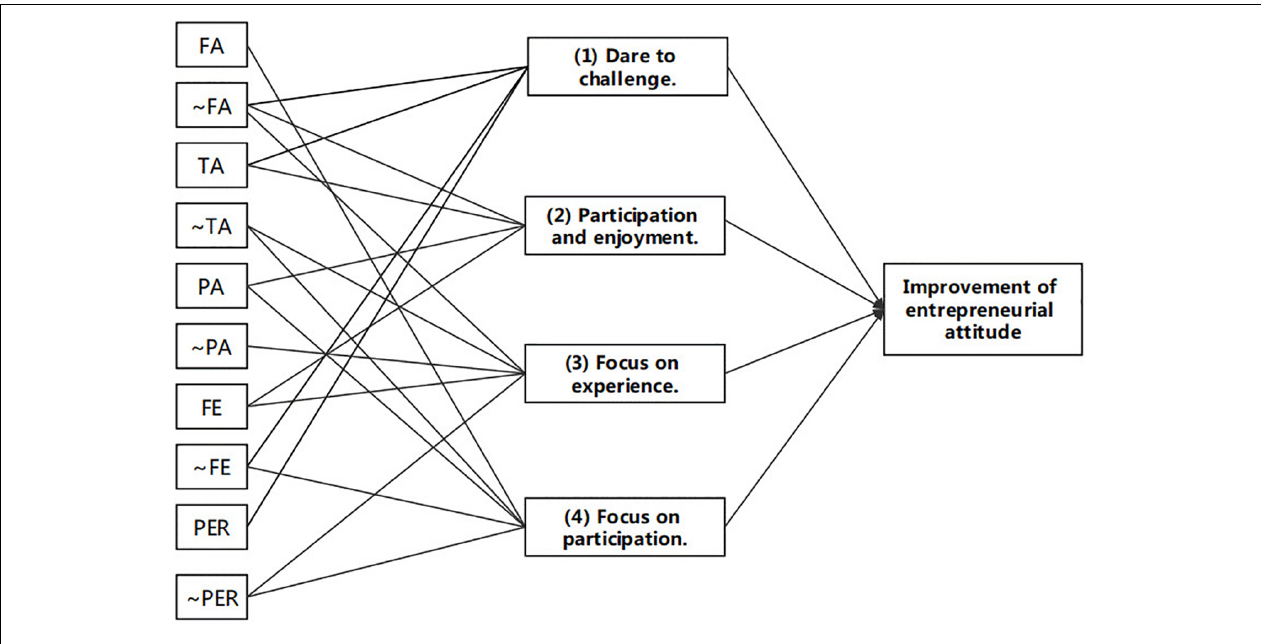
FIGURE 1 | Formation mode of entrepreneurship attitude